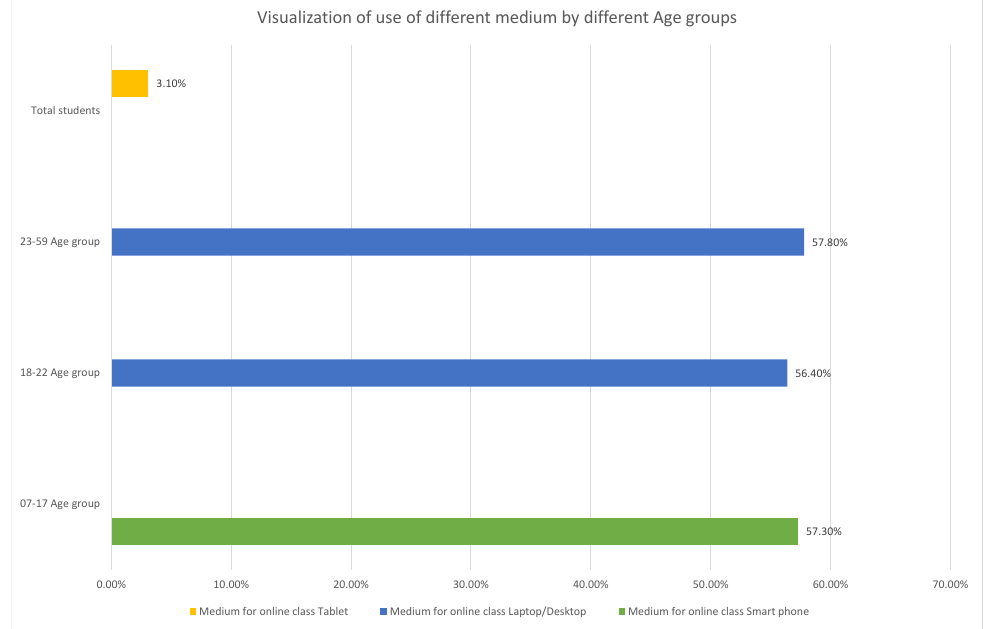
Figure 4. Visualisation of use of different gadgets by different age-groups